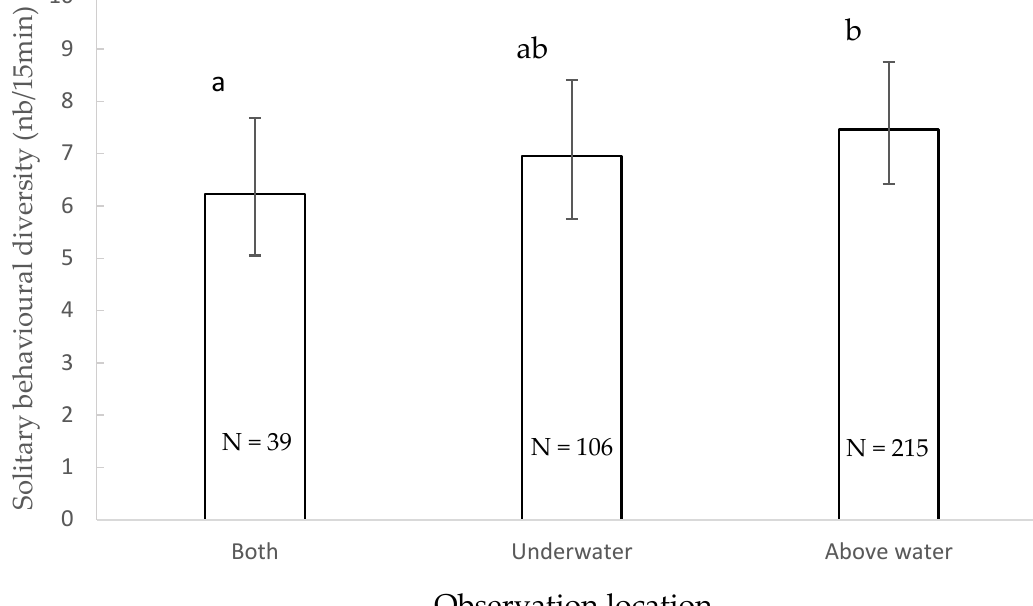
Figure 4. Mean of solitary behavioural diversity and 95% confidence intervals according to the observation location. Locations that share the same letter do not differ significantly and locations that have no letter in common tend to differ (Wald chi-squared test with sequential Bonferroni correction). N: number of observations.